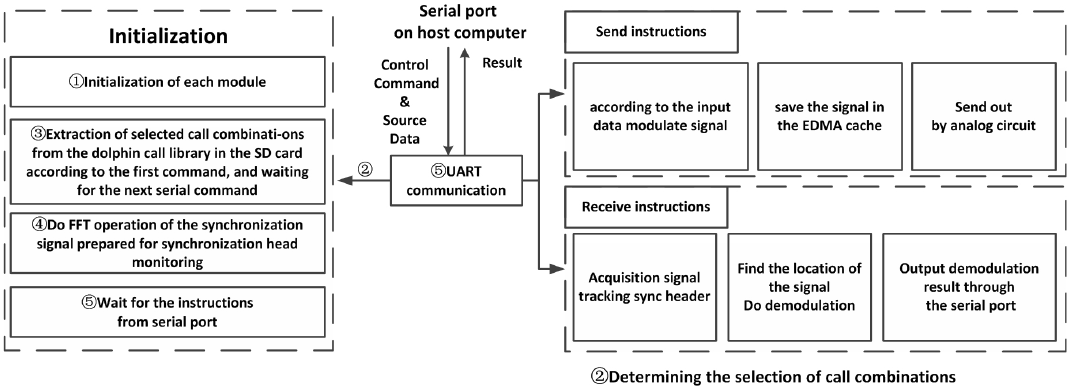
Figure 13. Software